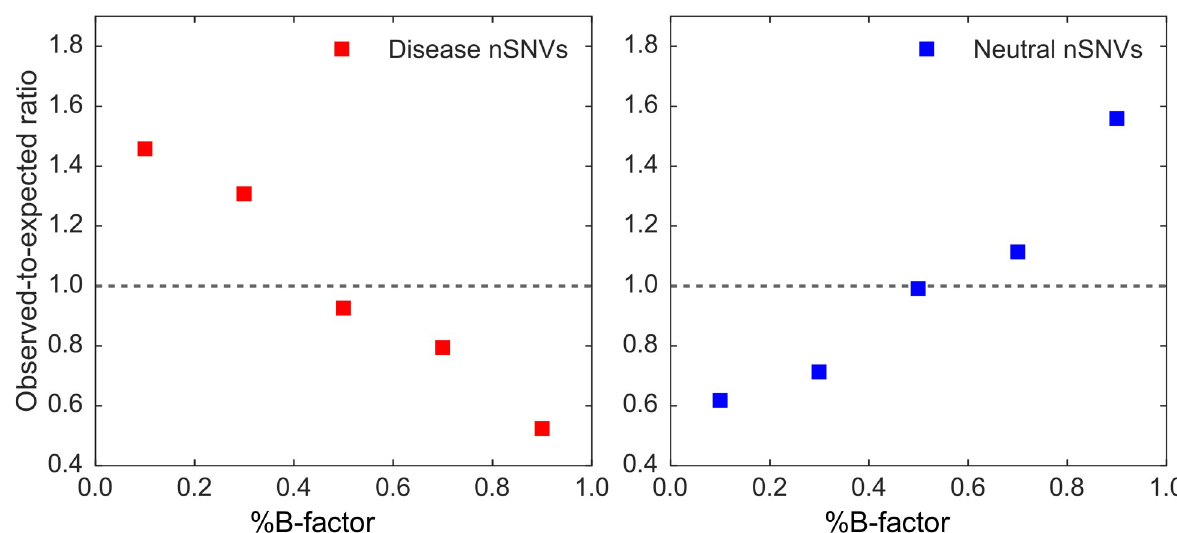
Fig 7. Observed to expected ratio plots for disease and neutral nSNVs. The relationship of observed-to-expected numbers between 436 disease nSNVs (red) and 302 neutral nSNVs (blue) from 139 human enzymes. The %B-factor scores derived from the Seq-GNM are binned into 5 bins of size